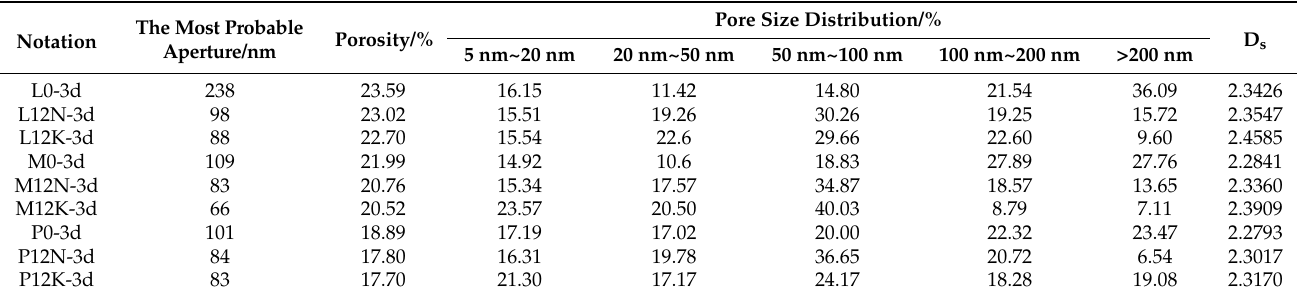
Table 4. The pore distribution and D s of mortars with different alkali sulfates contents at 3d.